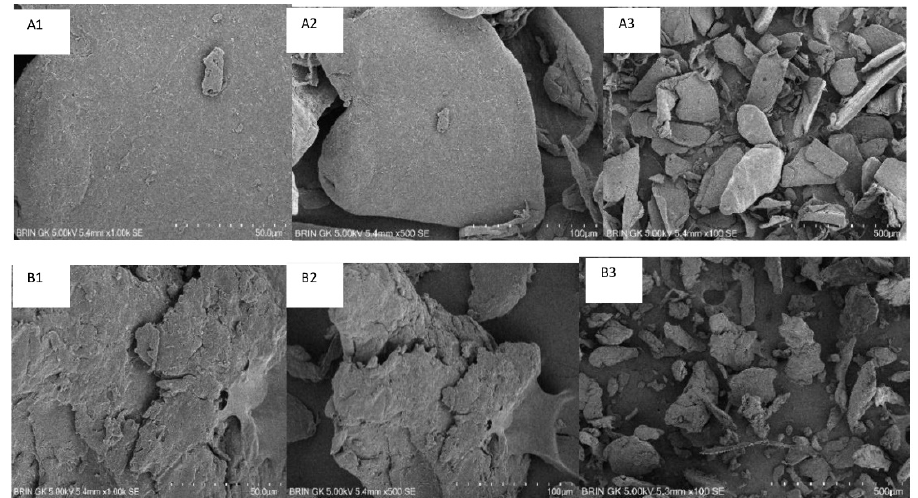
Figure 6. SEM of native chitosan magnification at 1000 × ( A1 ), 500 × ( A2 ), 100 × ( A3 ) and SEM of low molecular weight chitosan magnification at 1000 × ( B1 ), 500 × ( B2 ), 100 × ( B3 ).